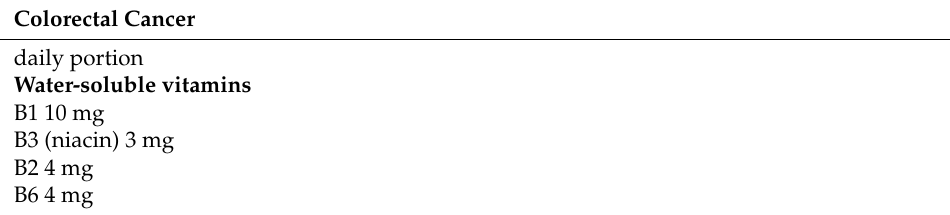
Table A1. Mixture composition (quantity per